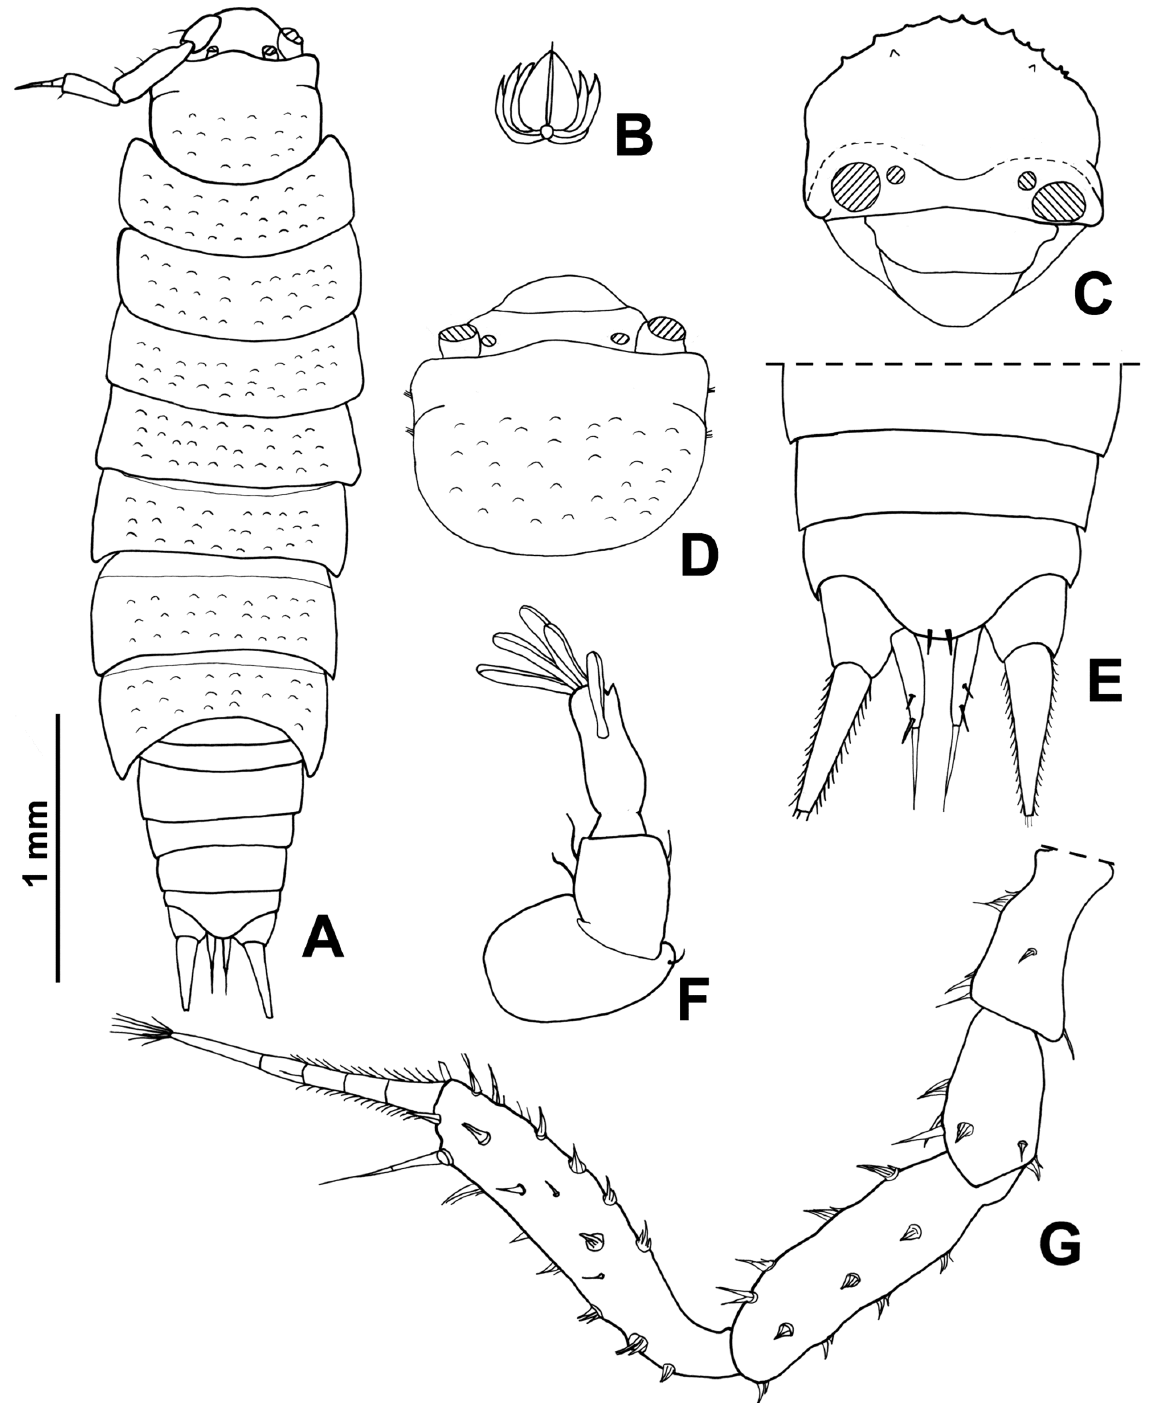
Fig. 23. Cordioniscus lusitanicus Reboleira & Taiti sp. nov. from Algar de Santo António, Estremoz- Cano. — Paratype, ♀. A . Adult specimen in dorsal view. — Paratype, ♂. B . Dorsal scale-seta. C . Cephalon in frontal view. D . Cephalon in dorsal view. E . Pleonites 4, 5, telson and uropods. F . Anten- nula. G .